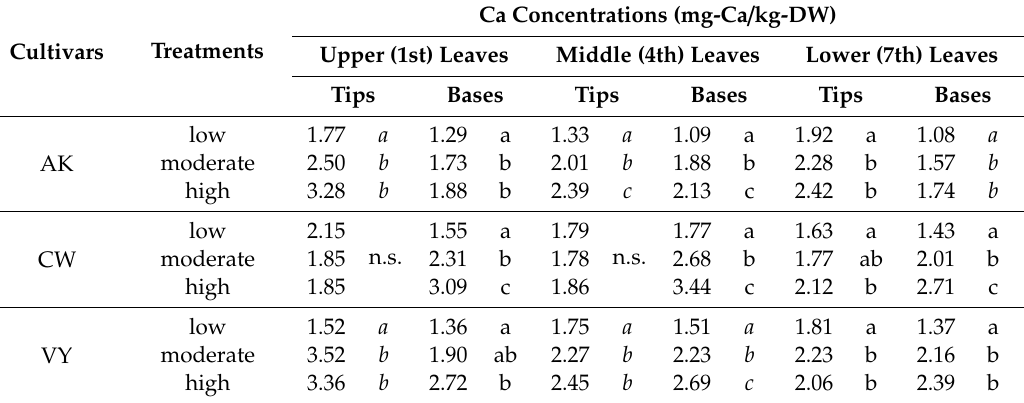
Table 4. Ca concentrations in the tips and bases of upper (1st), middle (4th), and lower (7th) leaves for each cultivar and treatment at the end of the experiment.